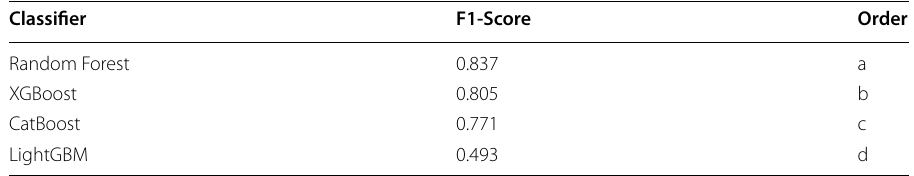
Table 13 Tukey’s HSD Results for F1 Score: Classifier Factor